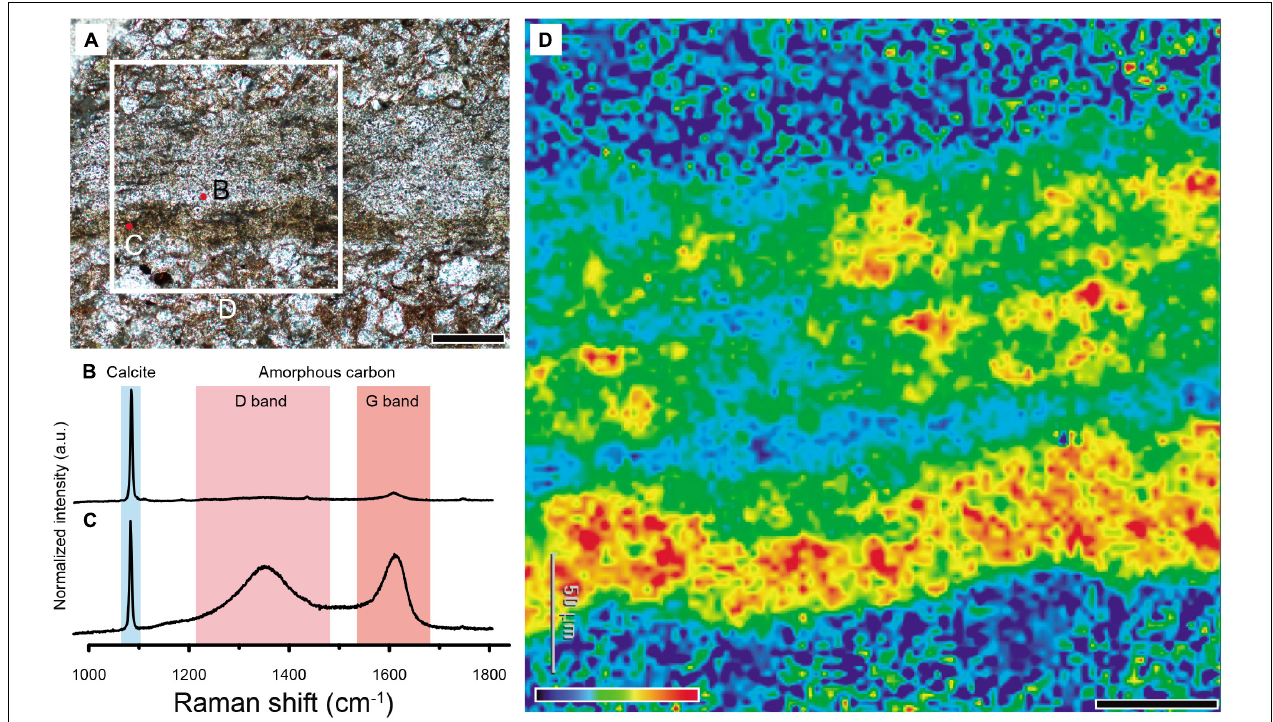
FIGURE 8 | Detection of amorphous carbon in Aenigmaoolithus vesicularis oogen. et oosp. nov. (A) An analyzed thin section (SNUVP 201702). Point analysis was carried out in the translucent region and a dark band (marked by red dots), respectively. The mapped region is marked by a white square. (B) The Raman spectrum acquired at the translucent region. Note calcite peak and very weakly developed G band. (C) The Raman spectrum acquired at the dark band. Note well-developed (G,D) bands as well as calcite peak. (D) The Raman mapping of the eggshell. The detecting frequency was set on the 1600 cm − 1 (G band). Note the dark band in the inner end of the eggshell is highly enriched with amorphous carbon. Scale bars equal 100 µ m (A) ; 50 µ m (D)